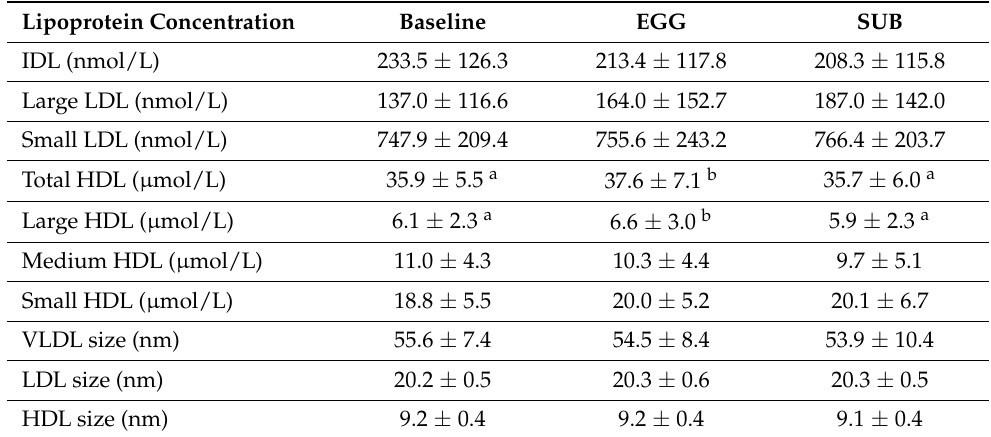
Table 5. Lipoprotein particle concentrations and subfraction analysis from fasting plasma of MetS participants (n = 24) at baseline and after EGG or SUB diet for 4 weeks each *.